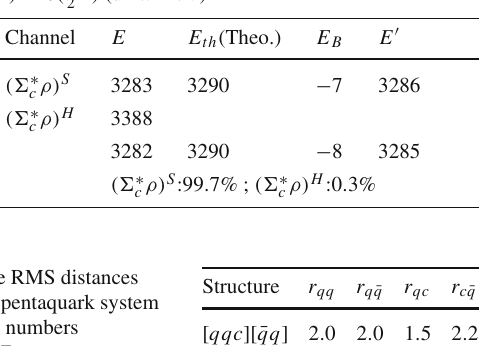
Table 11 The energies of the qqq ¯ qc pentaquark system with quantum